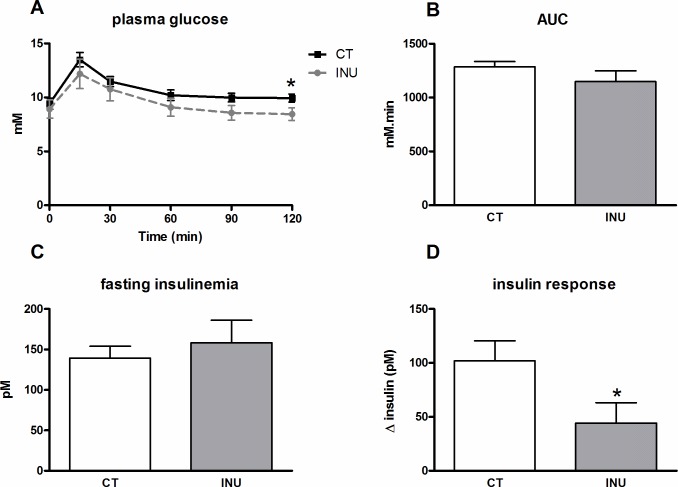
Effect of inulin extract addition (5%) in the sucrose solution on the postprandial blood glucose and serum insulin levels in sucrose-loaded mice fed a control diet.Plasma glucose excursion after the oral sucrose load (A), area under the curve (AUC) of the glucose excursion (B), fasting insulinemia (C) and insulin response (Δ insulin concentration 30 min before and 15 min after the oral sucrose load) (D). *p<0.05 (Student t test).